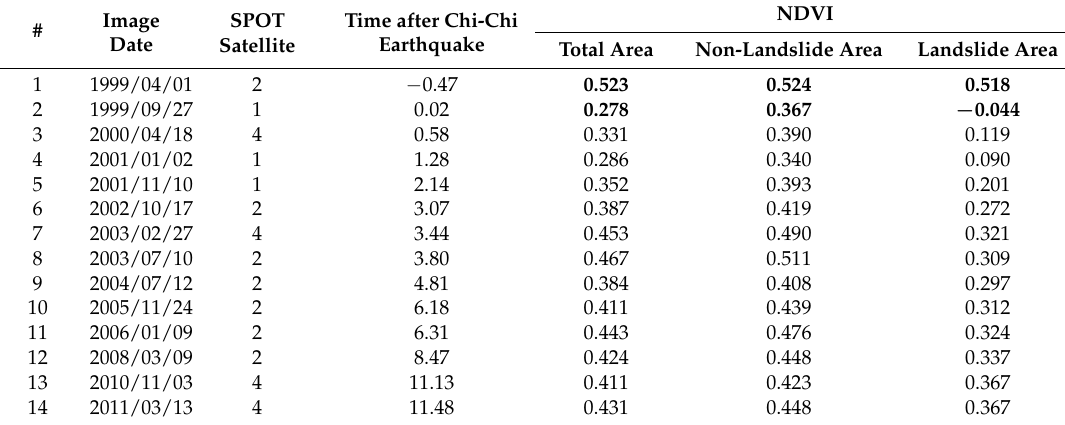
Table 1. NDVI values derived from SPOT satellite images. Image date is provided in yyyy/mm/dd